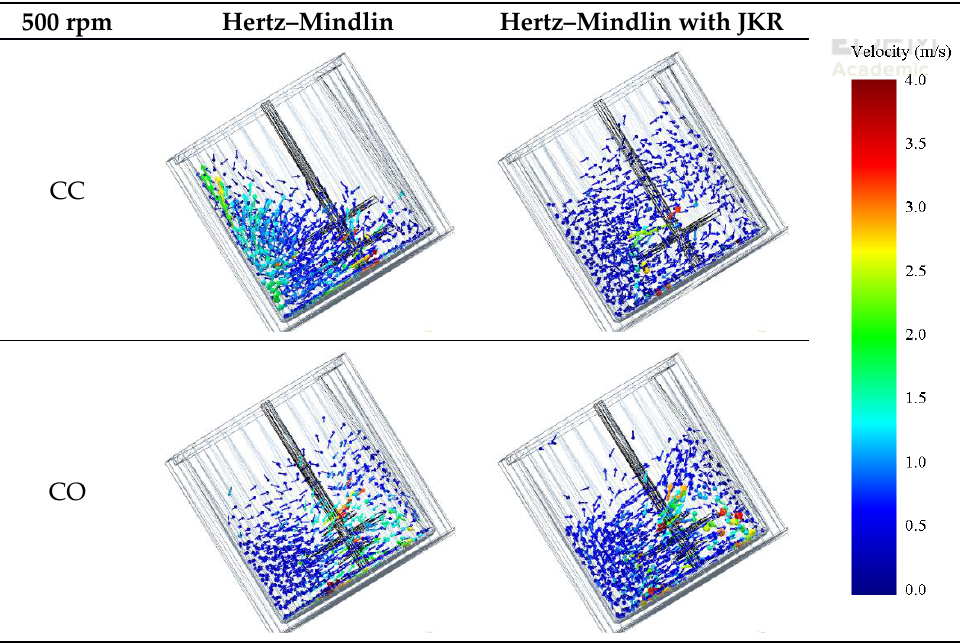
Figure 6. Comparison of simulated velocities of particles for the different contact models and modes of operation for an impeller frequency of 500 rpm.